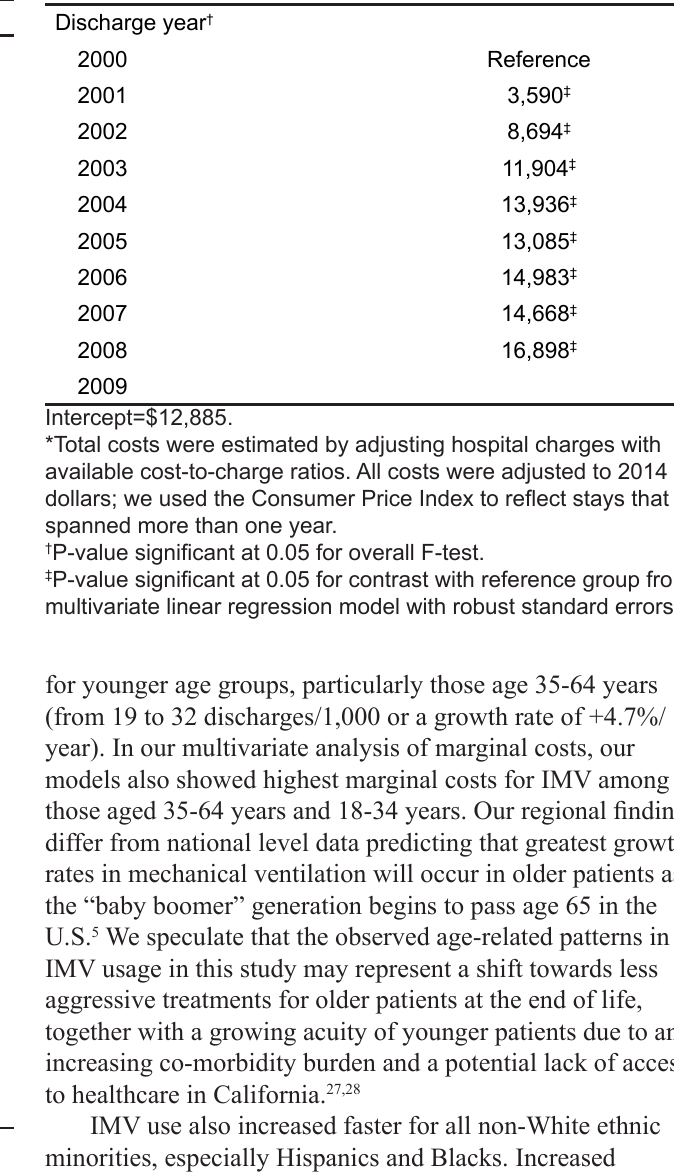
Table 3. Marginal cost per invasive mechanical ventilation discharge in California,